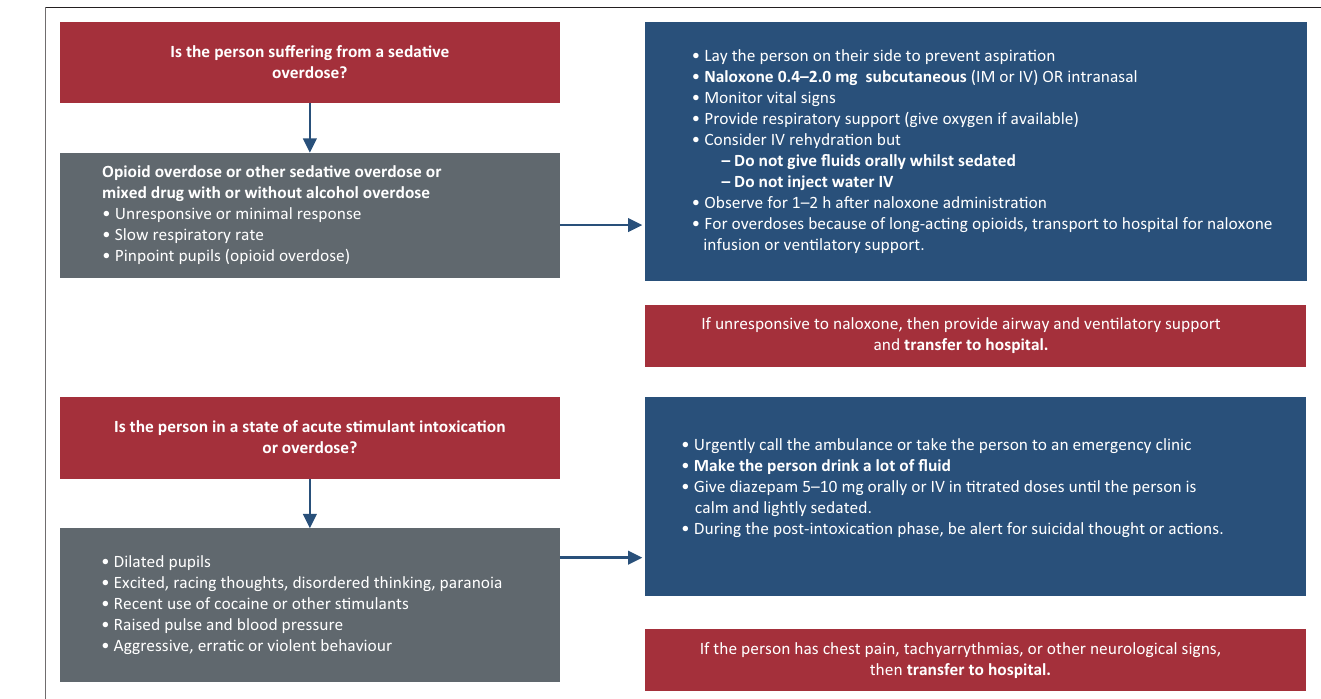
Is the person suffering from a seda(cid:13)ve overdose?